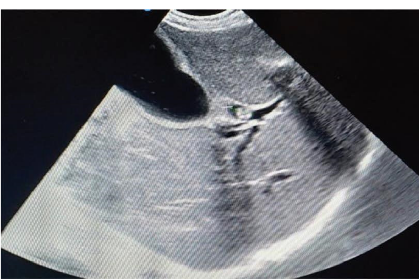
Figure 1: Ultrasound image of ascaris worm in the common bile duct, transverse section.